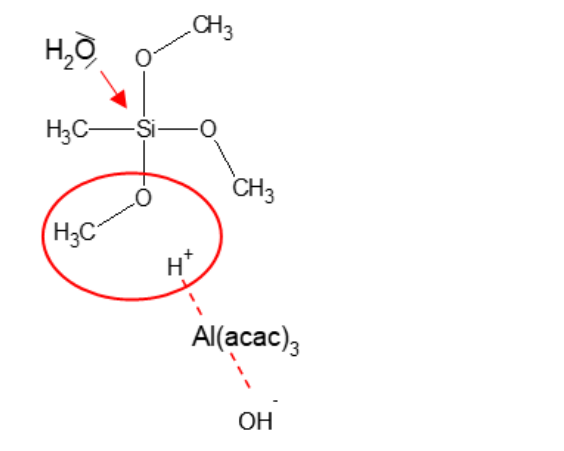
Figure 1. Transition state developed in solution according to alkoxysilane hydrolysis mechanism with applying aluminum acetylacetonate (Al(acac) 3 ) [18].